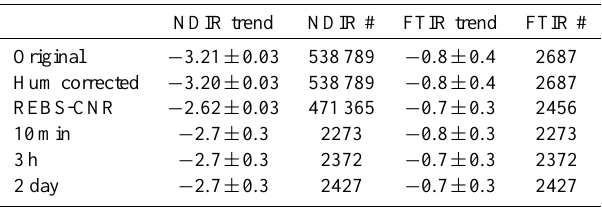
Table 1. NDIR and FTIR CO trend in ppbyear − 1 and number of data points (#) for the original raw data (Orginal), after humidity correction (Hum corrected), after humidity correction and REBS- CNR filtering (REBS-CNR) and after all the above and using either ± 10min, ± 3h or ± 2 day overlap times.